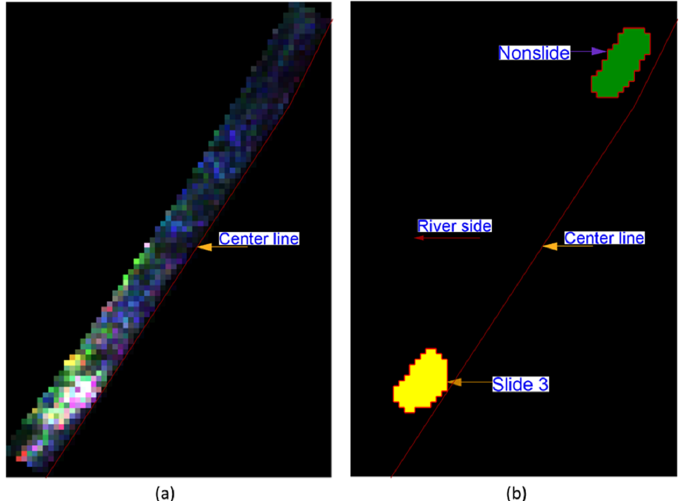
Figure 6. ( a ) Segmented test area SAR image; and ( b ) classification training classes; overlaid with the levee center line.